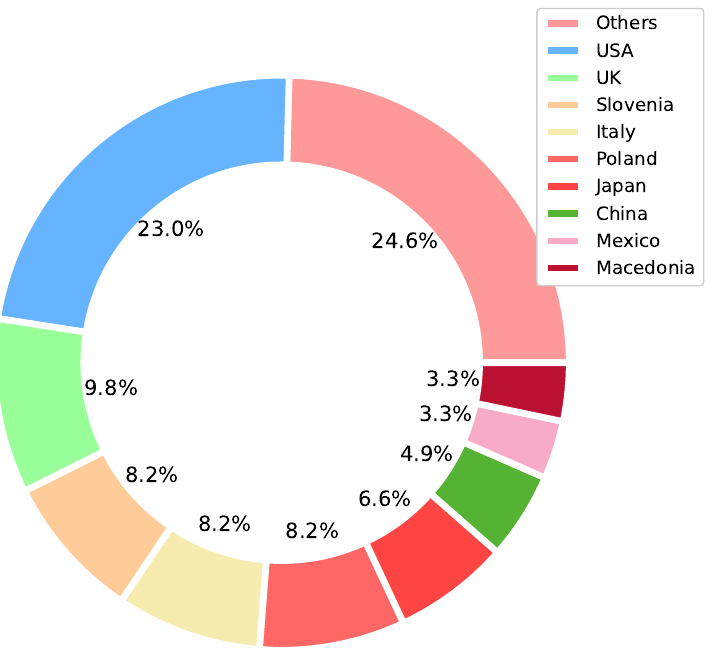
Figure 2. Country of first author